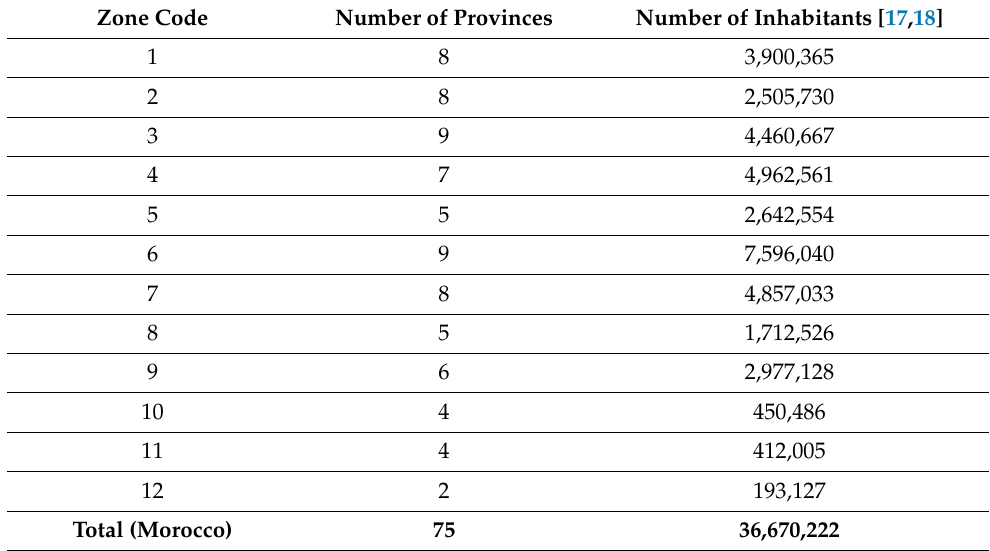
Table 1. Regional Distribution in Morocco.